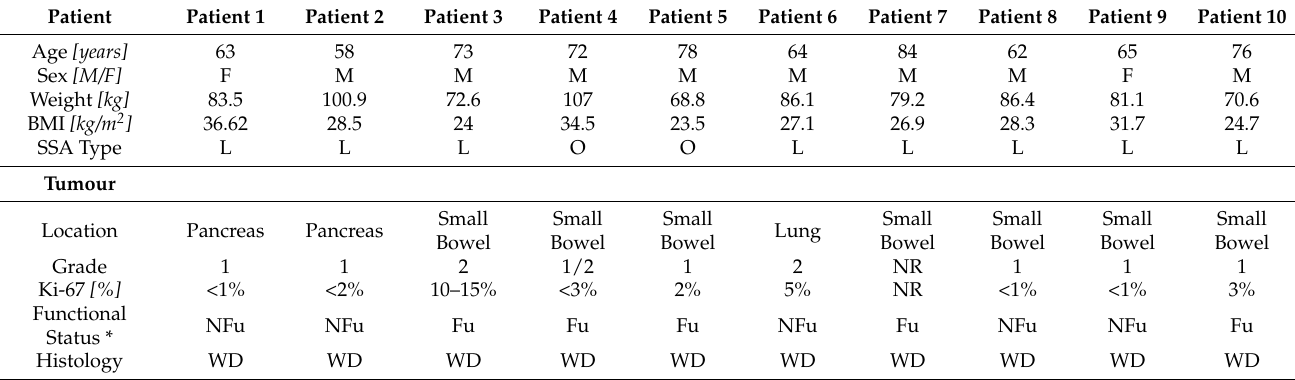
Table 1. Baseline